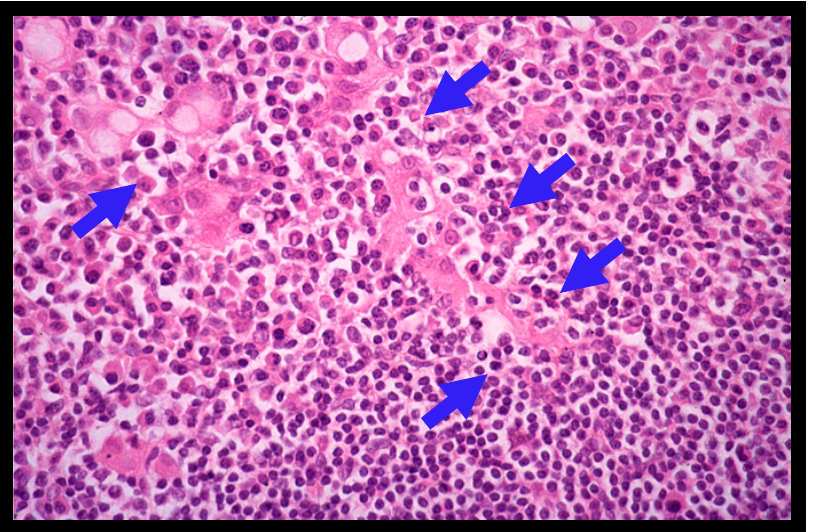
Figure 2. Histological features of gastric MALT lymphoma (H&E; X400). Diffuse infiltrate of small- to medium-sized atypical neoplastic lymphoid cells (centrocyte-like cells) around reactive follicles with a marginal zone growth pattern is shown. Lymphoepithelial lesions (LELs) (blue arrows) are also shown.